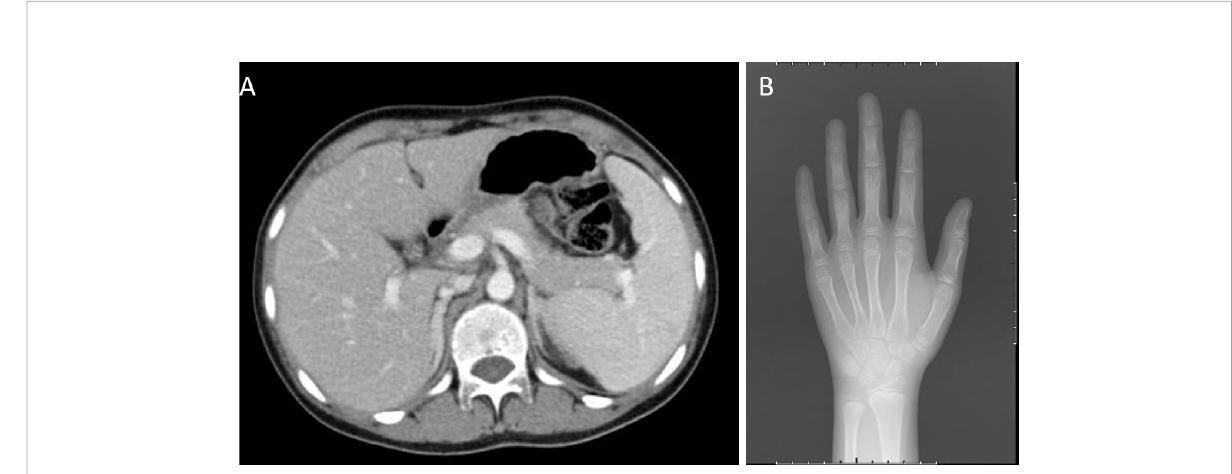
FIGURE 2 Imaging examinations. (A) An abdominal CT scan revealed no apparent hyperplasia in the bilateral adrenal gland. (B) X-ray showed her bone age was 8 years